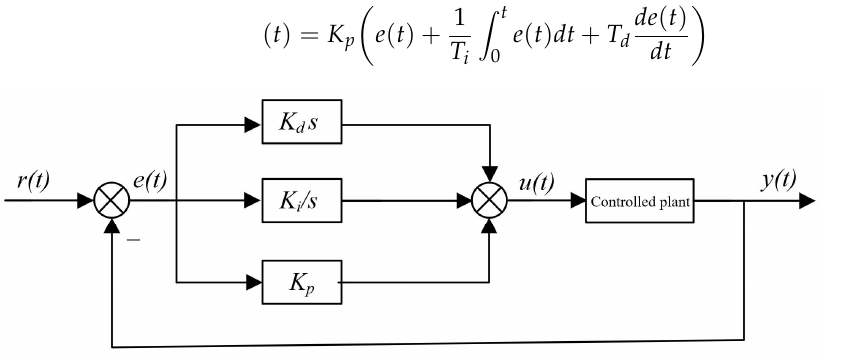
Figure 5. Schematic of PID process.